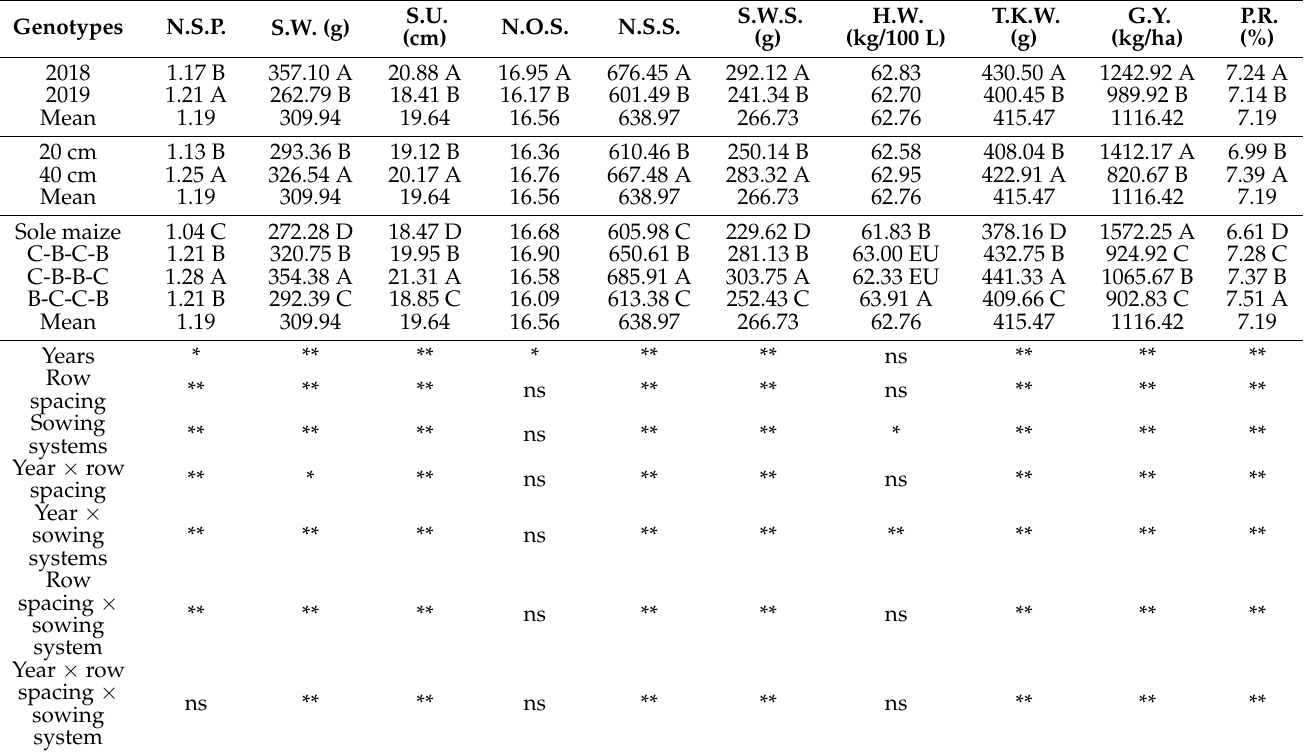
Table 5. Evaluating the effects of different sowing treatments on yield characteristics examined in maize in the study area of Nur Sultan,